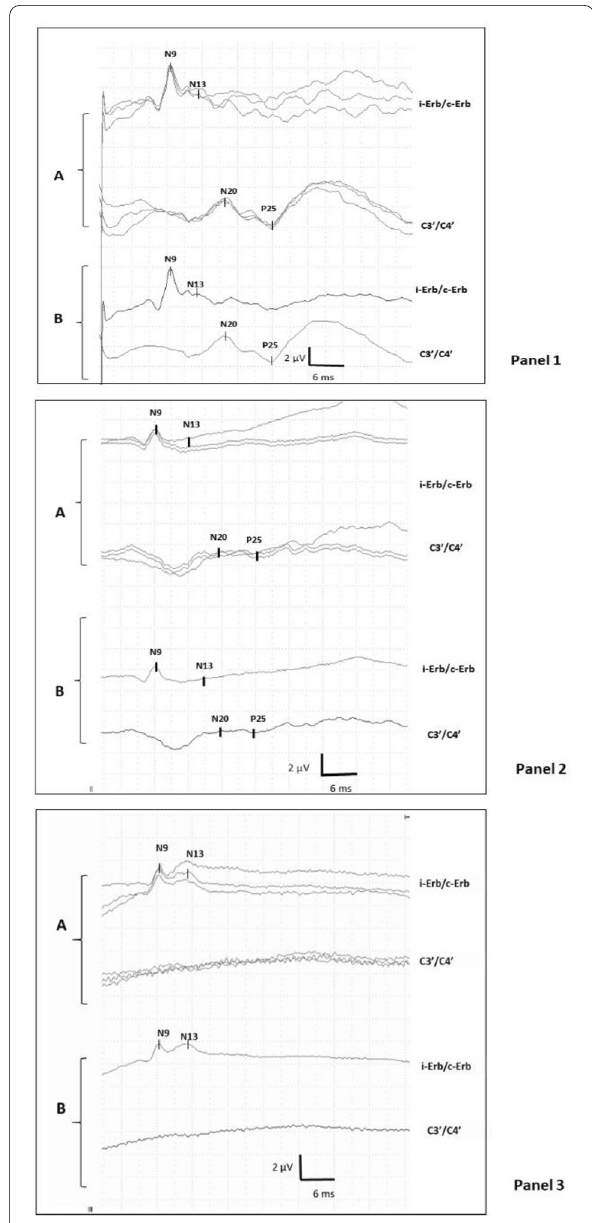
Fig. 1 Two channels median SSEPs after stimulus of the right median nerve. In a normal SSEP (panel 1), the channels show the cortical responses N20 and P25, the spinal component (N13) and the peripheral component (N9). In the panel 2, N20 and P25 were presented but amplitudes were reduced. In the panel 3, N20 and P25 were absent; A superposed Evoked Potentials; B averaged Evoked Potentials. i-Erb ipsilateral Erb’s point, c-Erb contralateral Erb’s